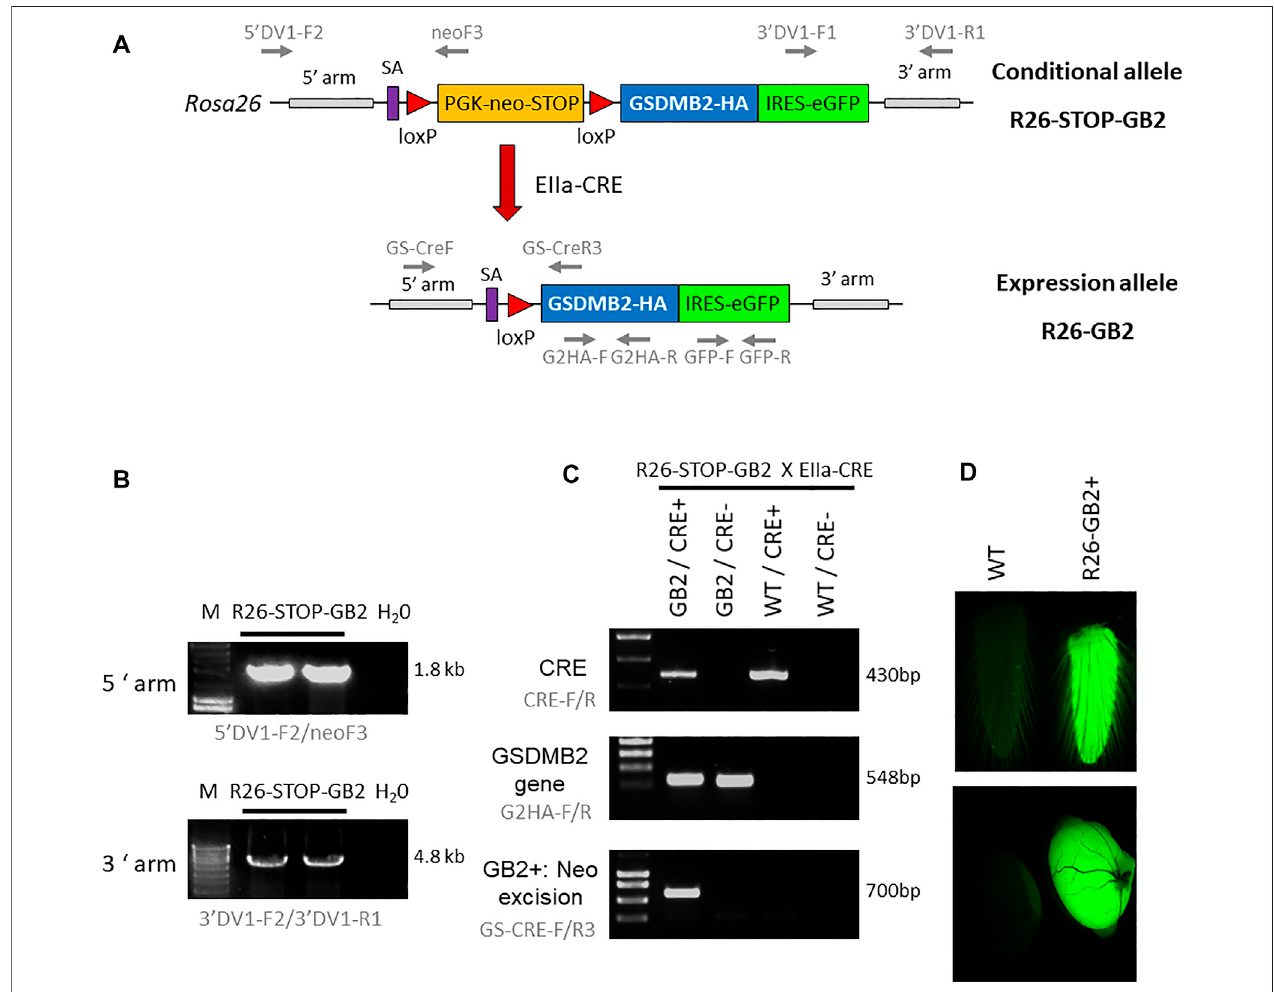
FIGURE 1 | Generation of knock-in mouse models harboring human GSDMB isoform 2 transcript within the ROSA26 locus. (A) Schematic representation of the GSDMB isoform 2 (GB2) targeted fl oxed allele (top, conditional model) and the expression allele (bottom) within the ROSA26 (R26) locus. The construct contains a splicing acceptor signal (SA), the PGK-neomycin-STOP cassette fl anked by LoxP sites, the human GSDMB2 isoform 2 cDNA sequence (GB2) fused with HA tag, followed by the IRES-GFP reporter gene. After crossing with EIIa-Cre strain (red arrow), the Cre-mediated excision of the PGK-neomycin-stop element allows the ubiquitous expression of the GB2-HA/GFP tandem under the control of the ROSA26 promoter (R26-GB2). The primer pairs for PCR analyses are also detailed (gray arrows). (B) Diagnostic PCR analysis of positive ES cell clones showing the proper insertion of the recombinant R26-STOP-GB2 allele. H20, Negative control. (C) Examplesofgenotyping PCRanalysis(primers in gray), demonstrating the excision ofneo-stop casseteinCre+/GB2mice. (D) Ubiquitous expression ofthetransgenes is veri fi ed by GFP fl uorescent emission of fresh tail skin (top) and testes (bottom) from WT and GSDMB-positive R26-GB2 mice. Full-length gels are presented in Supplementary Figure S1